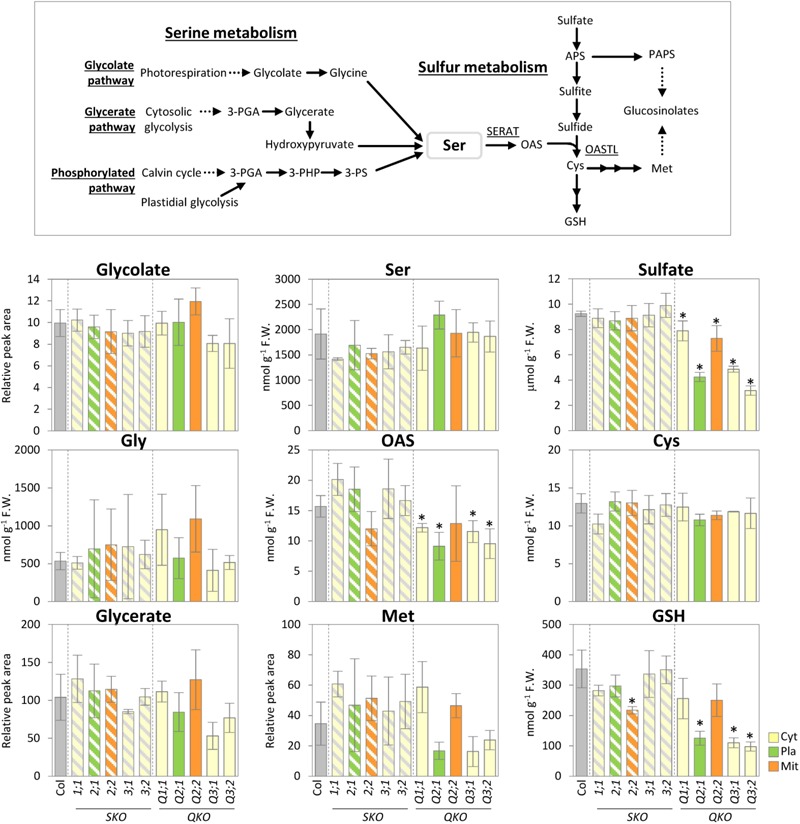
Accumulation of serine and sulfur metabolism in serat mutants. Schematic representation of serine and sulfur metabolism and changes of the selected metabolites in rosette leaves of 25-day-old plants. Contents of glycolate, glycerate, and Met were determined by Gas Chromatography/Time of Flight-Mass Spectrometer (GC/TOF-MS) analysis, contents of OAS, Ser and thiols (Cys and GSH) by HPLC analysis and sulfate by ion chromatography. In GC/TOF-MS analysis peak area was normalized to sample fresh weight and the peak area of internal standard. Data represent the mean (±SD) of three biological replicates. Differences between the wild type and serat mutants were analyzed using Student’s t-test and were marked when statistically significant (∗P < 0.05). Abbreviations: 3-PGA, 3-phosphoglycerate; 3-PHP, 3-phosphohydroxypyruvate; 3-PS, 3-phosphoserine; Ser, serine; OAS, O-acetyl serine; APS, 5′-adenosine phosphosulfate; PAPS, 3′-phosphoadenosine-5′-phosphosulfate; Cys, cysteine; GSH, glutathione; Met, methionine; SERAT, serine acetyltransferase; OASTL, O-acetylserine(thiol)lyase. Cyt, cytosol; Pla, plastids; Mit, mitochondria. SKO, serat single mutants (hatched bars); QKO, serat quadruple mutants (color bars).